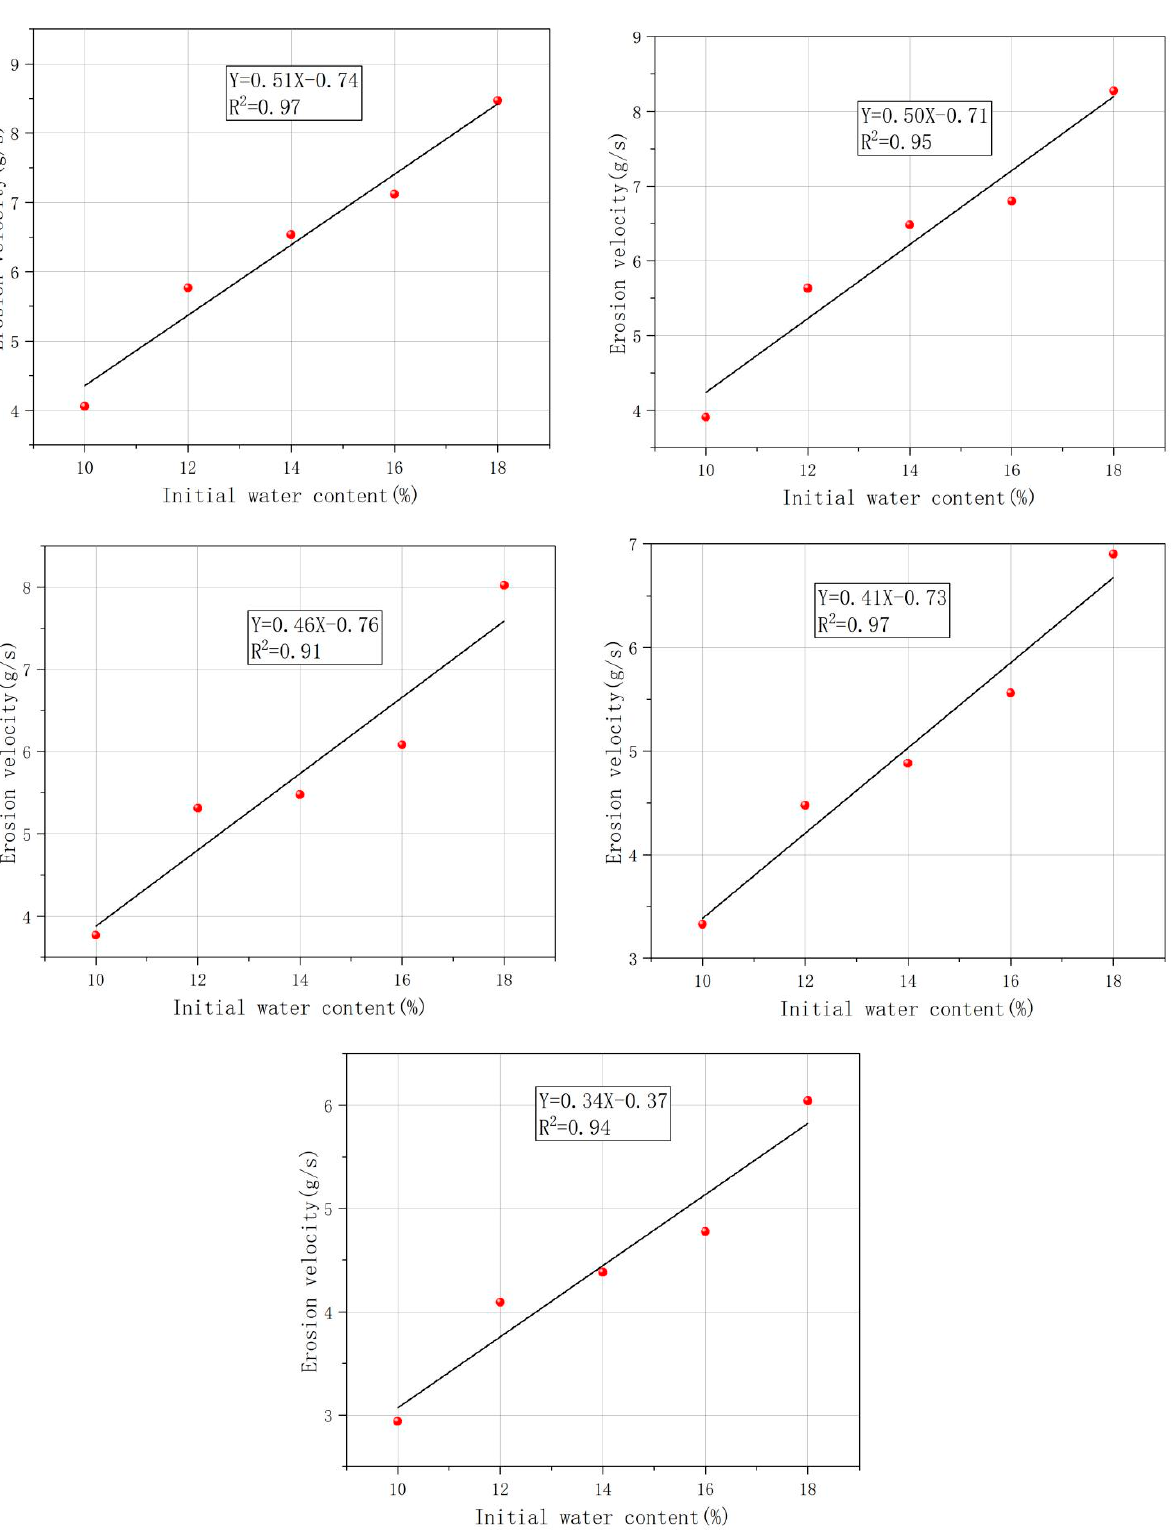
Figure 7. The inverse correlation between loess erosion velocity and the initial water content.